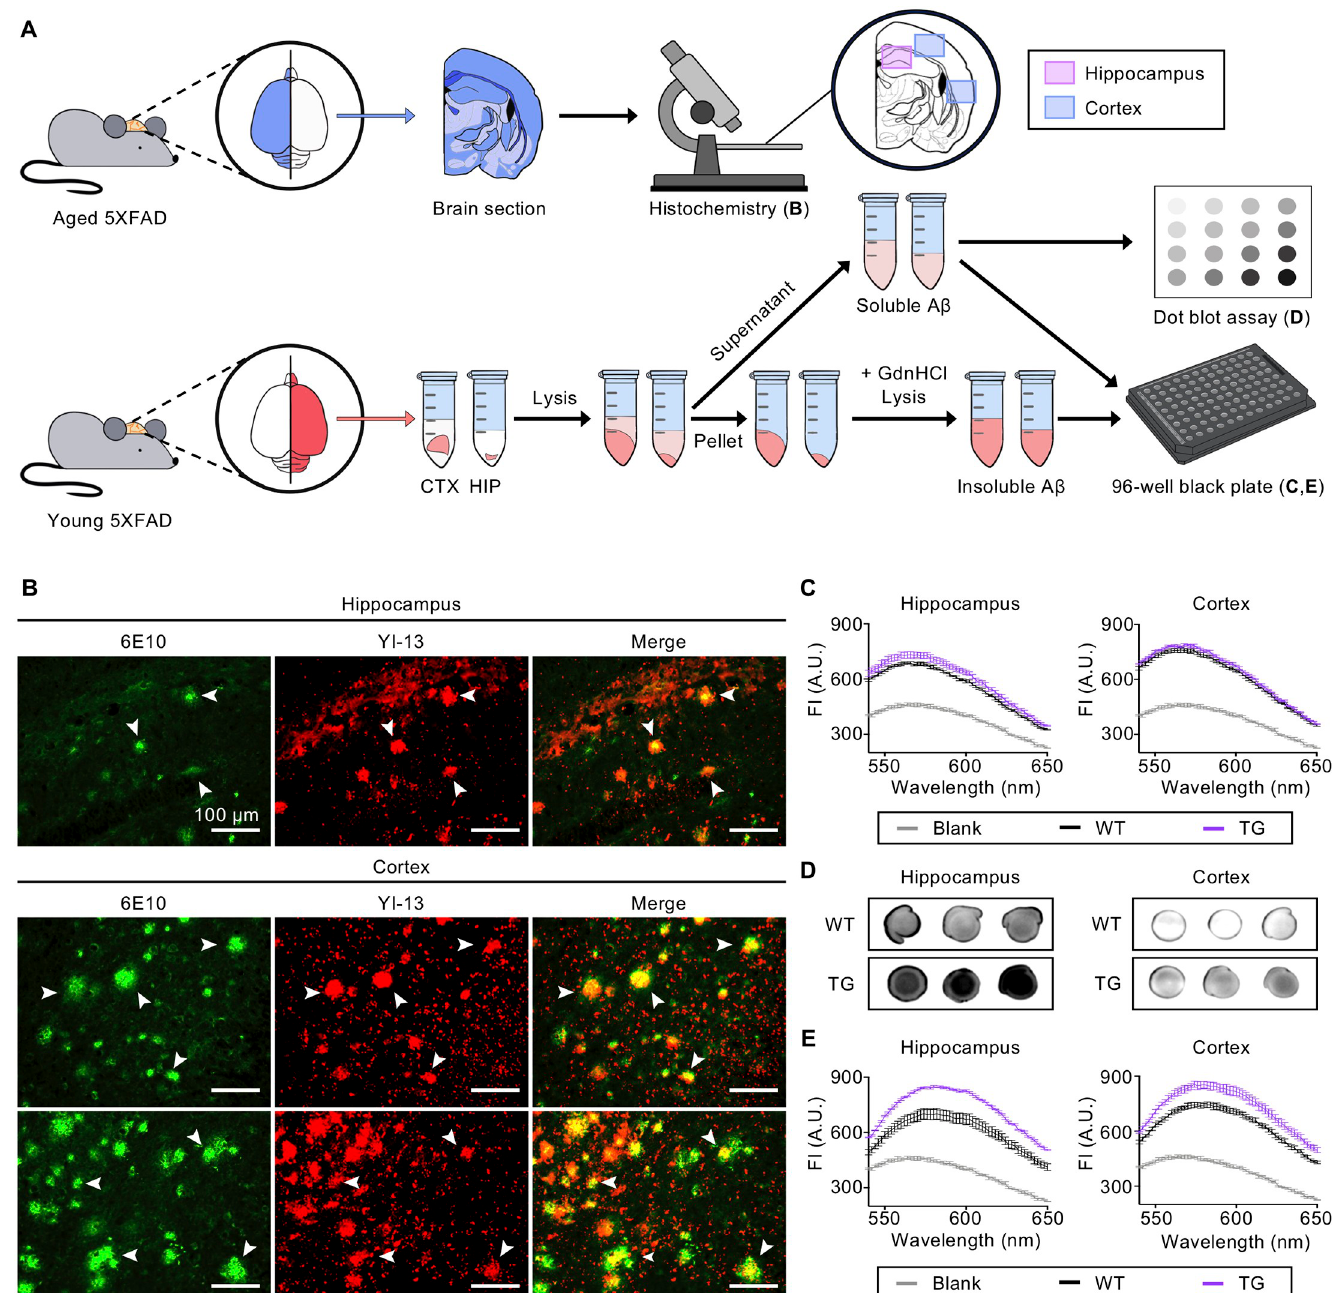
Fig 4. Ex vivo analyses of fluorescent YI-13 to confirm it as an imaging agent targeting insoluble and soluble A β . (A) A scheme of YI-13 ex vivo analyses. A brain hemisphere of aged mice was used for histochemistry (TG and WT, 12-month old, n = 2 and 2). Dissected regions of young mouse brain hemisphere (TG and WT, 5-month old, n = 3 and 3) were lysed to obtain soluble A β and verified by fluorescence scans and dot blots. The pellet fraction was further lysed in guanidine- hydrochloride buffer (GdnHCl) to obtain insoluble A β and verified by fluorescence scans. The illustration was drawn using Adobe Photoshop software. (B) Brain slides of TG co-stained by 6E10 and YI-13 (500 μ M). Arrowheads indicate A β plaques (scale bars = 100 μ m). (C-D) Soluble A β obtained by brain lysis of TG or WT mouse was analyzed. (C) Fluorescence spectral scan of YI-13 (250 μ M) analyses (394/582 nm, ex/em). (D) Dot blot analyses. The levels of soluble A β were determined by using anti-A β antibody, 6E10. Original images of blotting analysis are shown in S5 Fig. (E) Insoluble A β obtained from pellet lysates was analyzed by fluorescence spectral scan of YI-13 (250 μ M) (394/582 nm, ex/em). Blank in each scanning graph indicates YI compound only without any A β sample. The data collected from WT littermates is shown in the (S6 Fig). Abbreviations: HIP = hippocampus, CTX = cortex, WT = wild-type, TG = transgenic, AU = arbitrary unit.